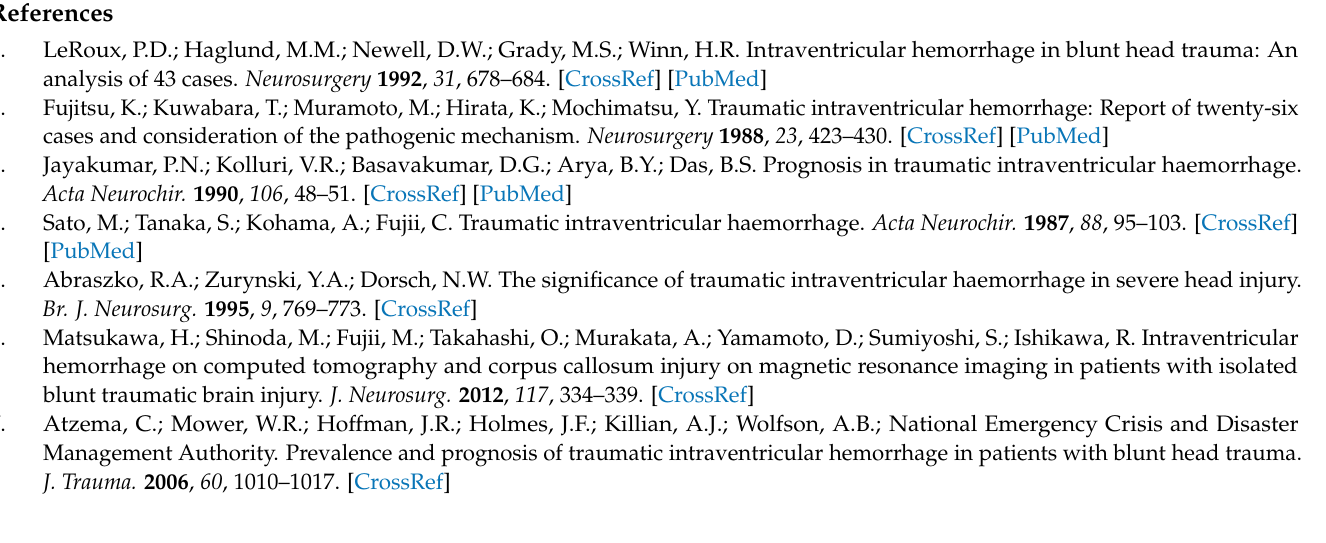
Table S2: ∆ AUC values of different models in predicting outcomes; Table S3: Traumatic Graeb score and outcomes of IVH in different ventricles AUC (95% CI). Table S4: Poor functional outcomes in different Traumatic Graeb